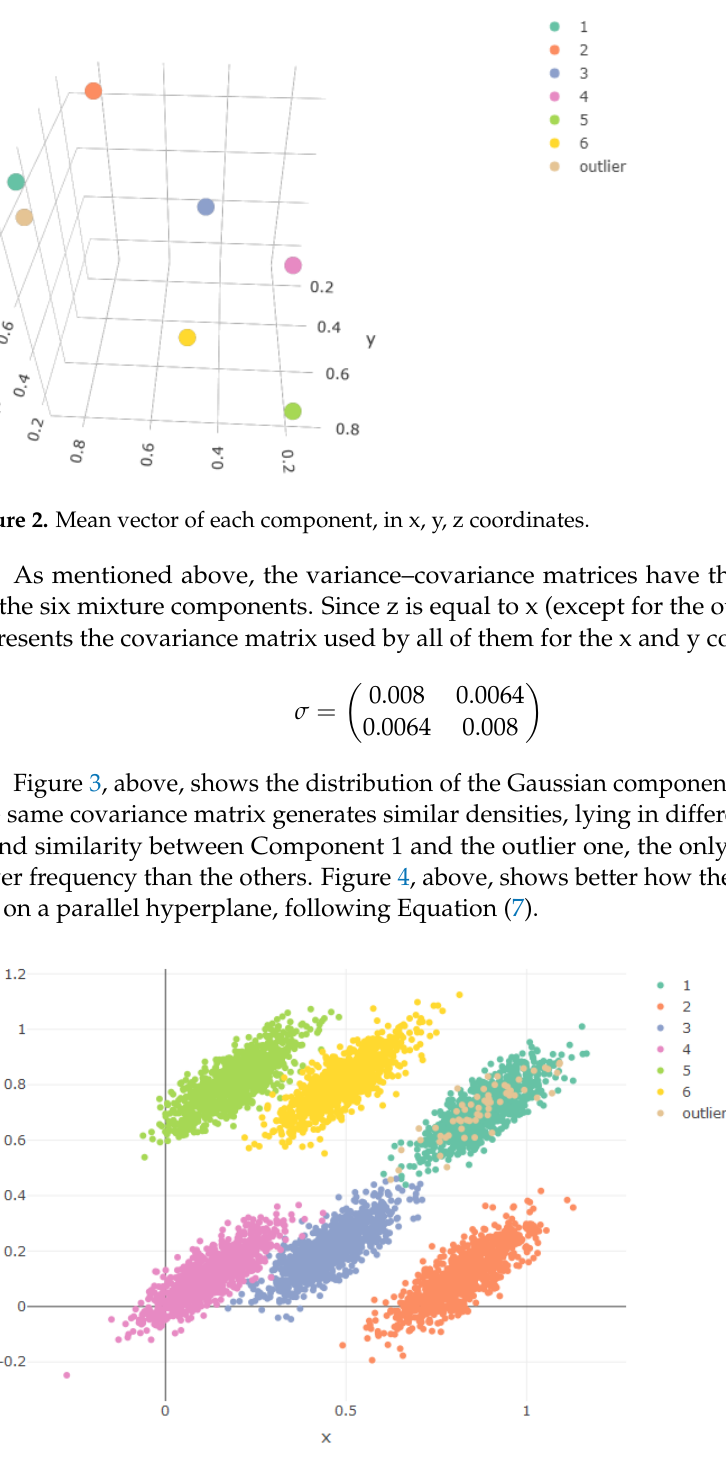
Figure 3. Generated